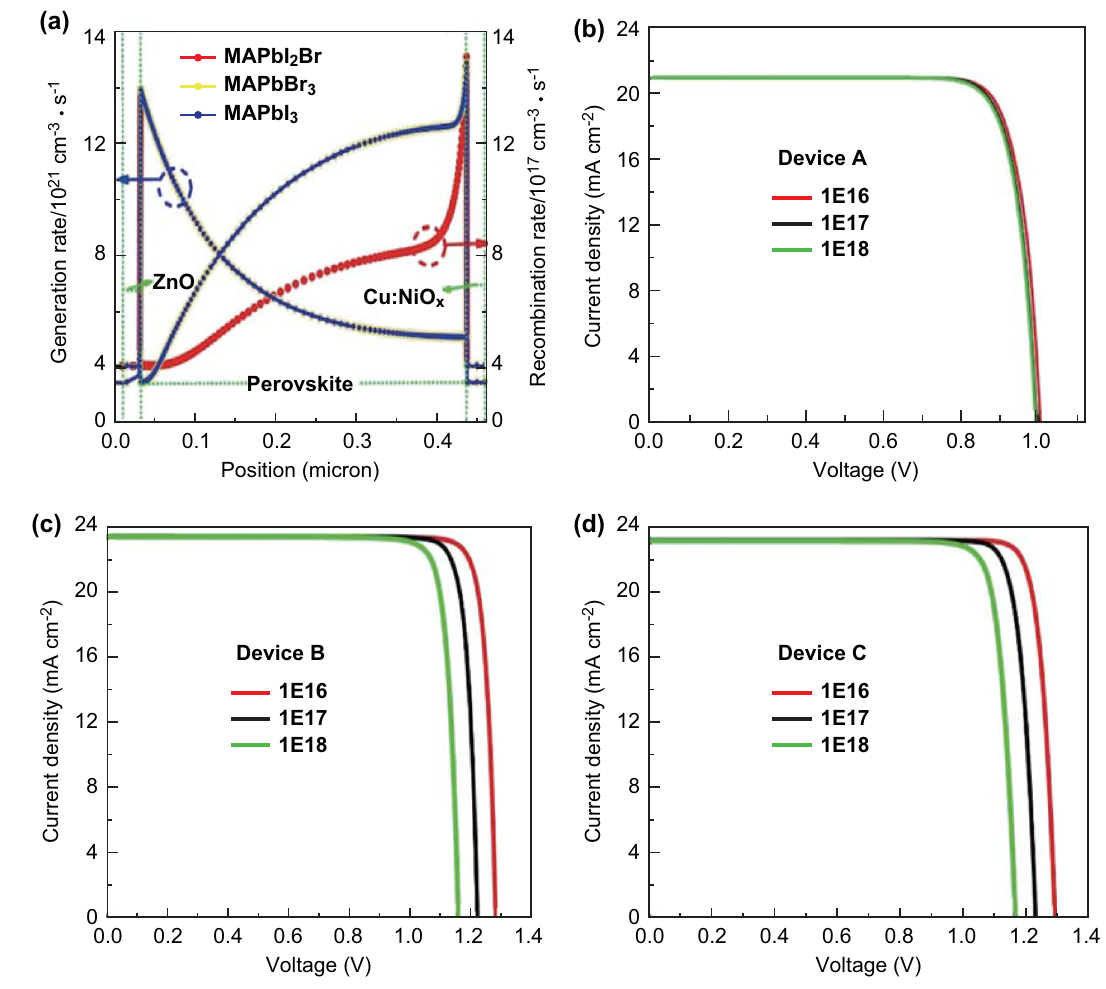
Fig. 2 a Simulated values of carrier recombination and generation rates in MAPbX (MA = CH 3 NH 3 , X = I 3 , I 2 Br, or Br 3 ) layers designed with Cu:NiO x (HTM) and ZnO (ETM). b – d Simulated J – V characteristic curves for different defect densities in the absorber